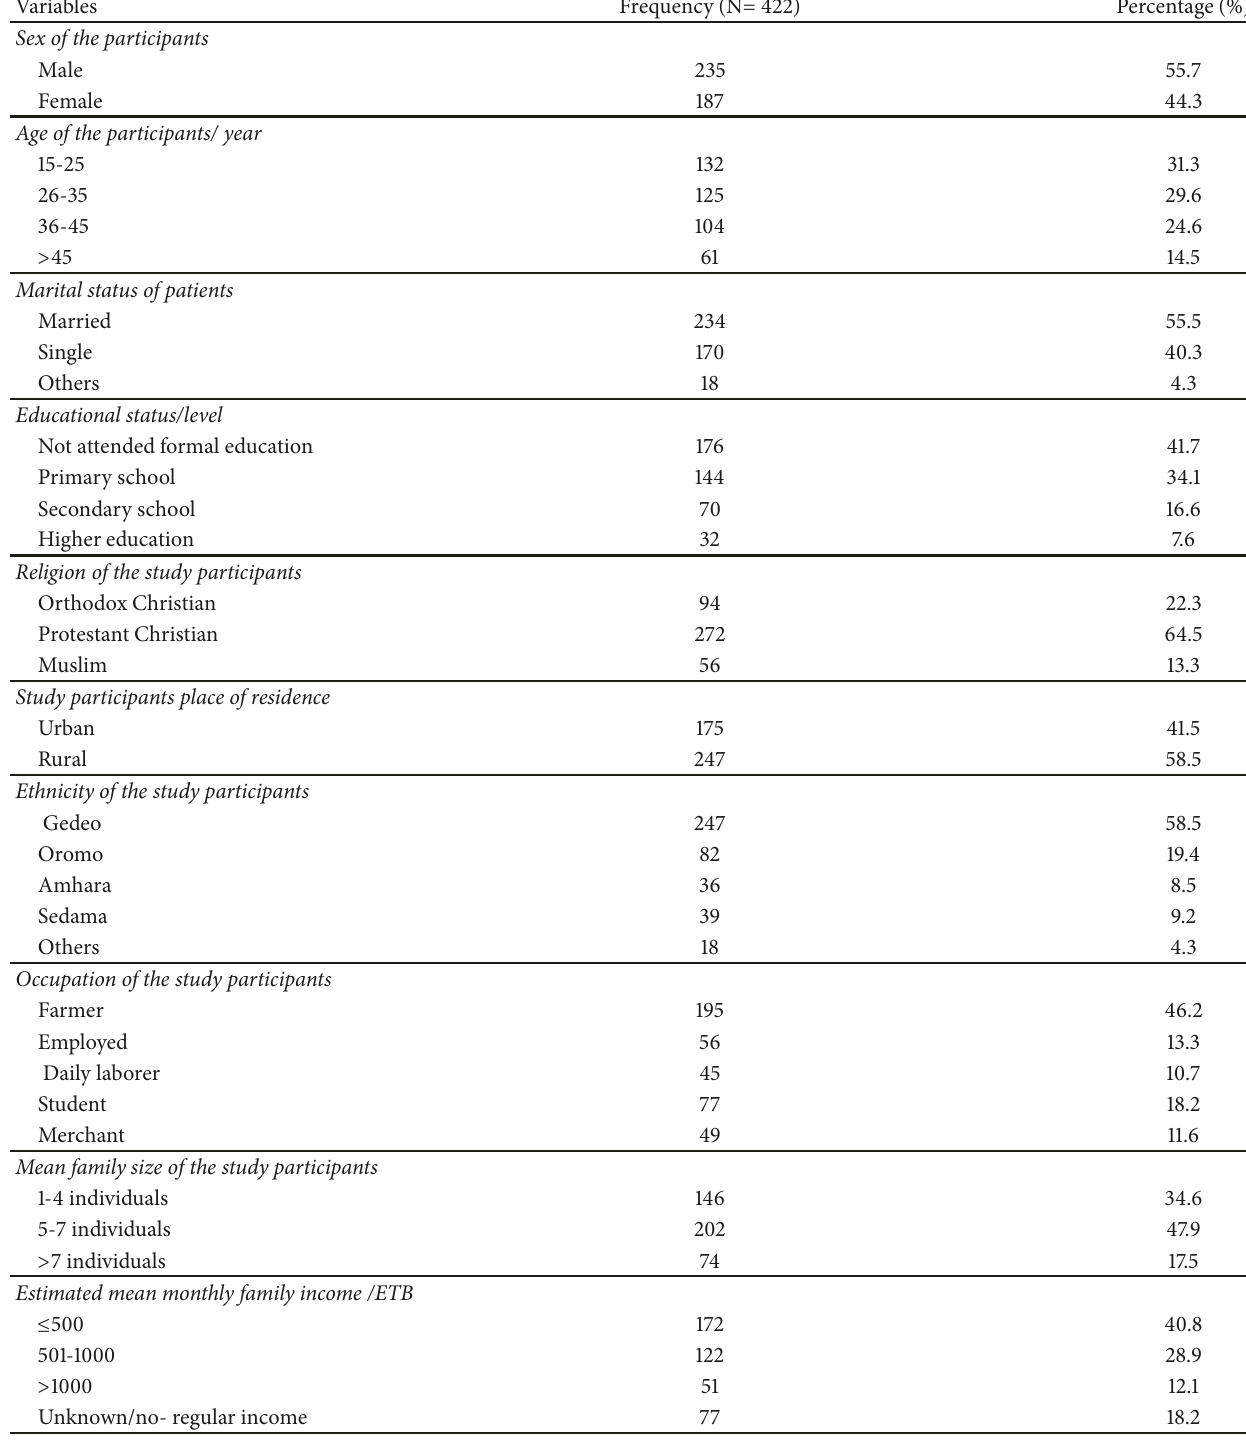
Table 1: Sociodemographic characteristics of the study participants among selected health facilities of Gedeo Zone, Southern Ethiopia,